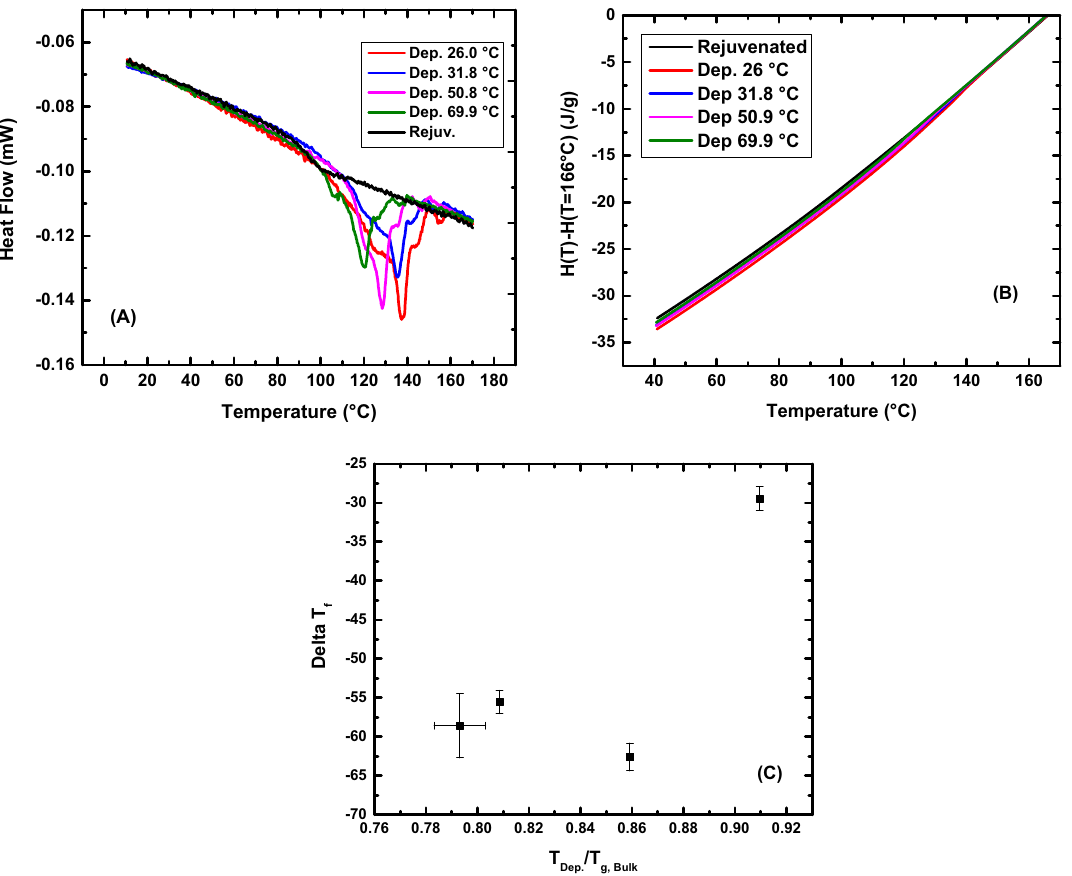
Figure 3. Summary of the VPD CYTOP calorimetry results. ( A ) Heat flow curves for stable CYTOP films of similar thickness (185–230 nm) deposited at different substrate temperatures. ( B ) Enthalpy curves for the stable CYTOP films created compared to the rejuvenated material. Enthalpy curves were calculated by integrating the heat flow curves. ( C ) T f reduction (delta T f ) relative to the rejuvenated CYTOP as a function of the ratio of deposition temperature and T g, Bulk . T dep was determined based on reported T g not the measured T g .